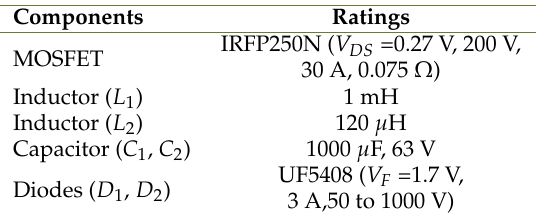
Table 3. EXPERIMENTAL SPECIFICATION OF FPB 3 C